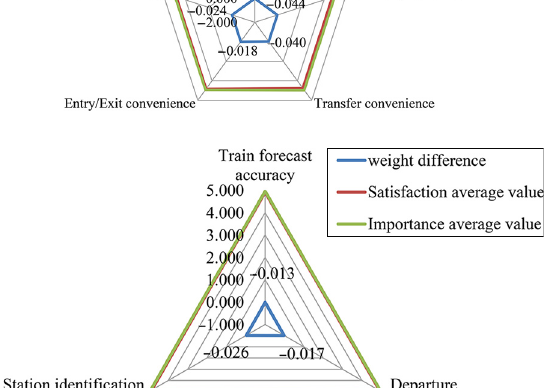
Figure 3. Weight differences of timeliness indicators